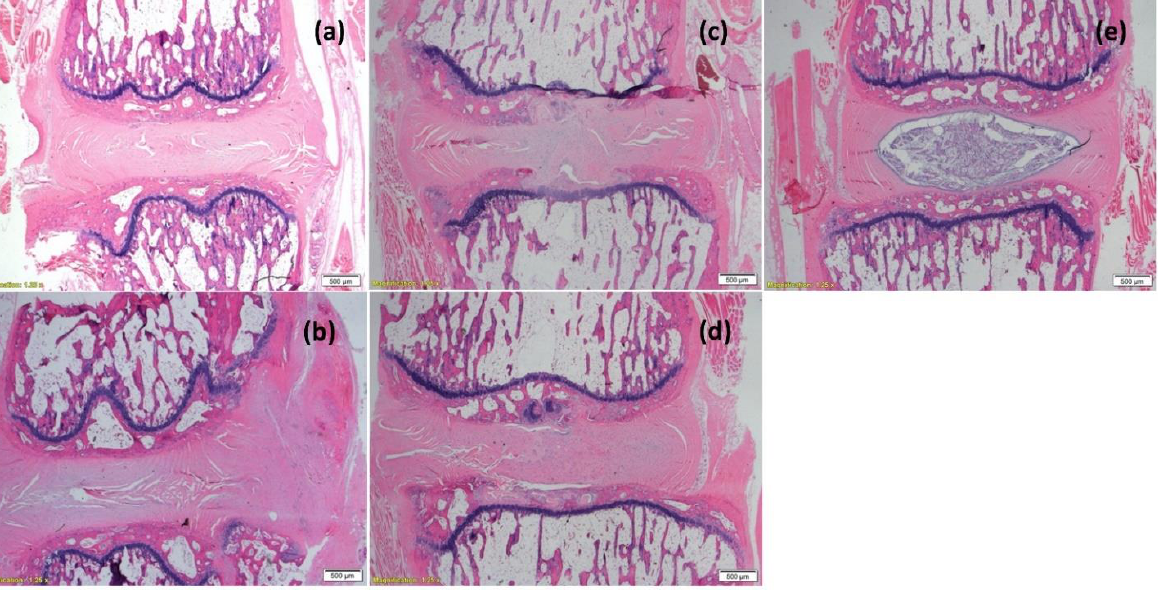
Figure 7. Cross section of two adjacent rat intervertebral caudal tail discs with damaged nucleus pulposus, 8 weeks post-implantation with 1.5% GAG-analogue hydrogel, showing: ( a ) empty hy- drogel (Rat #1); ( b ) hydrogel with empty alginate beads (Rat #3); ( c ) hydrogel with hBM-MSCs en- capsulated in alginate beads (Rat #5). Moreover, ( d ) a disc following nucleotomy (Rat #5), and ( e ) intact disc (Rat #7), are presented. Tails were harvested, fixed in 4% formalin, and stained with H&E. Scale bar is 500 µm.